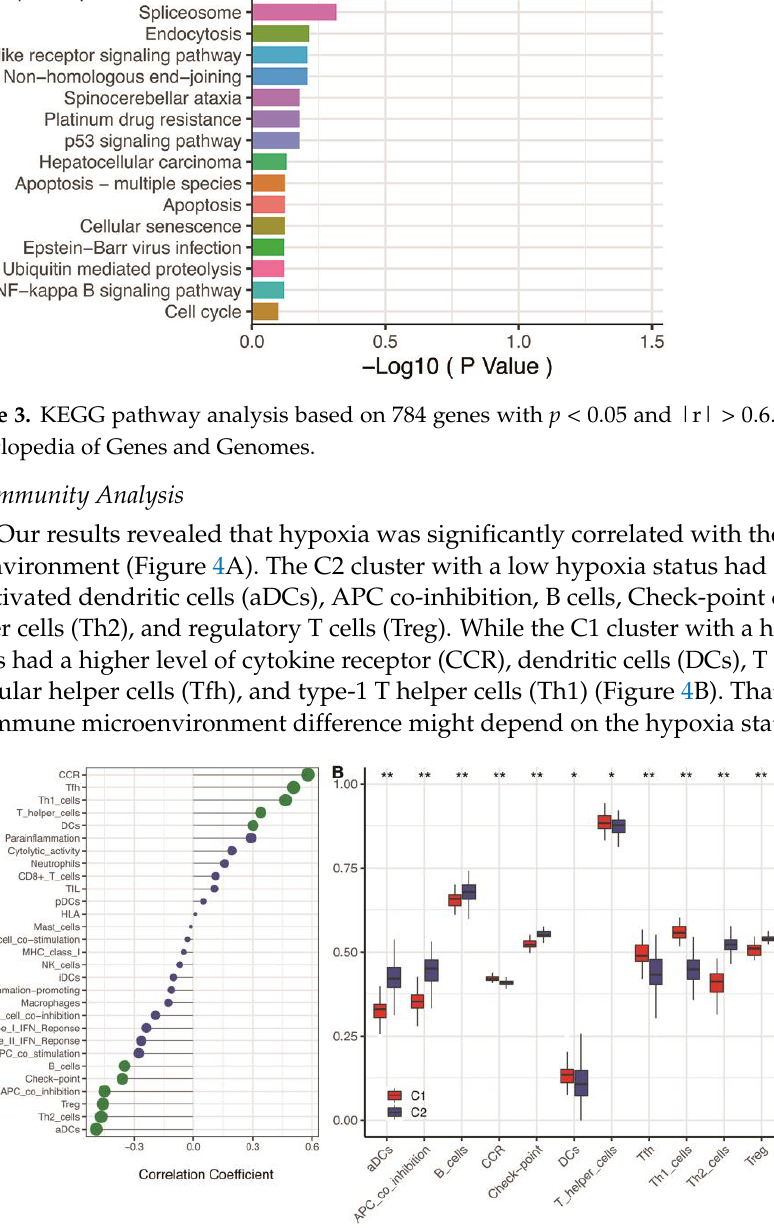
Figure 4. Immune cell levels of two hypoxia subtypes in the training cohort. ( A ) ssGSEA analysis based on 29 immune cellular components. ( B ) Box plots of immune cell infiltration in two subtypes. ** means p < 0.01; * means p < 0.05. ssGSEA: single-sample gene set enrichment analysis.